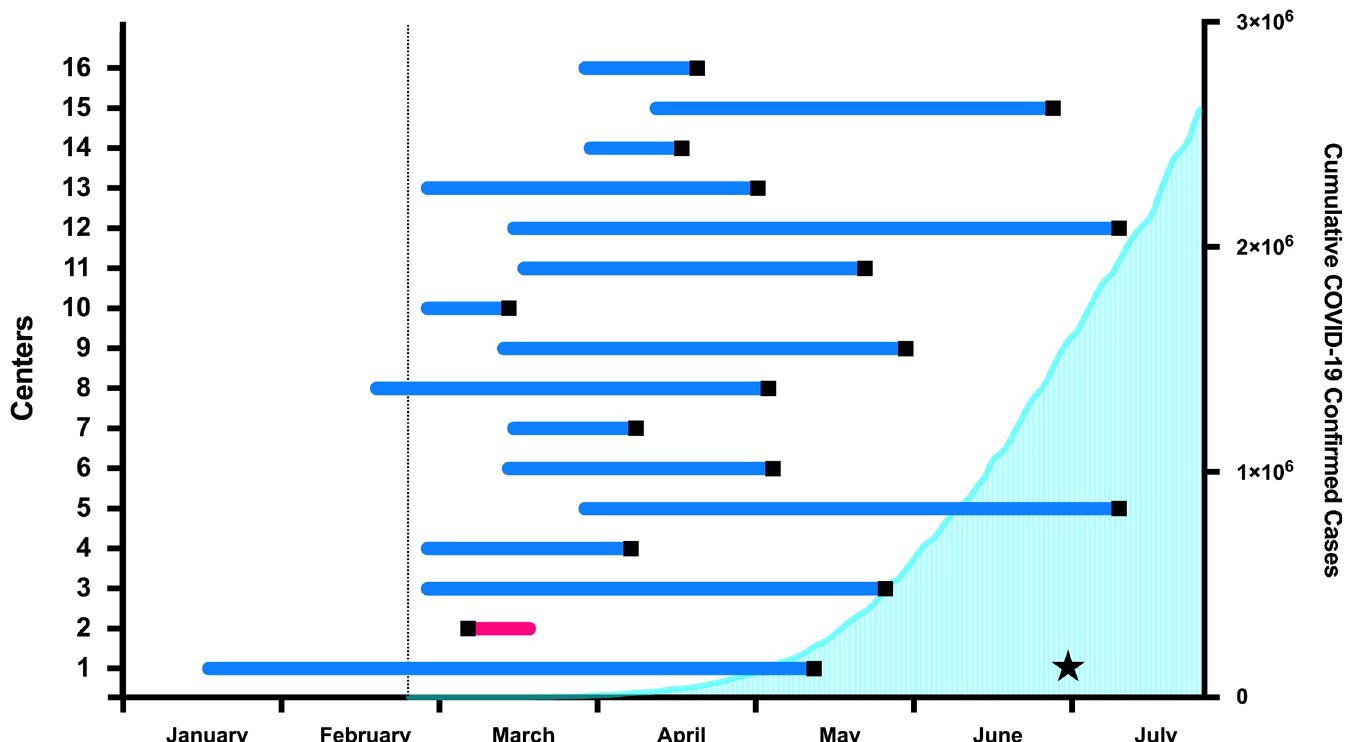
Fig 3. COVID-19 pandemic progression in Brazil concomitant with the implementation of the contingency and management (C&M) protocols in each REBRACO center. Horizontal bars represent the interval from C&M implementation and the first confirmed COVID-19 case in each center; blue indicates C&M implementation prior to the first case reported and magenta represents indicates C&M implementation after the first case. The black square in each bar indicates the first case recorded at each center. The star represents the initial date of COVID-19 universal screening at center 1. Turquoise curve represents the cumulative number of confirmed cases in Brazil until July 31, 2020. Vertical dashed line marks the first confirmed case registered in Brazil [2, 13].